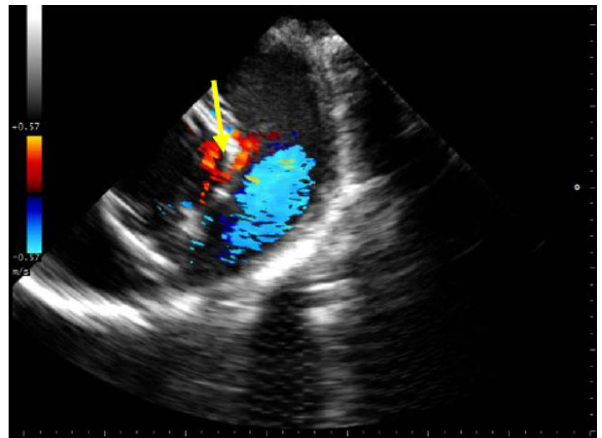
Figure 5. Cross-sectional image of the cardiac base showing the RV outflow tract and supracristral interventricular communication